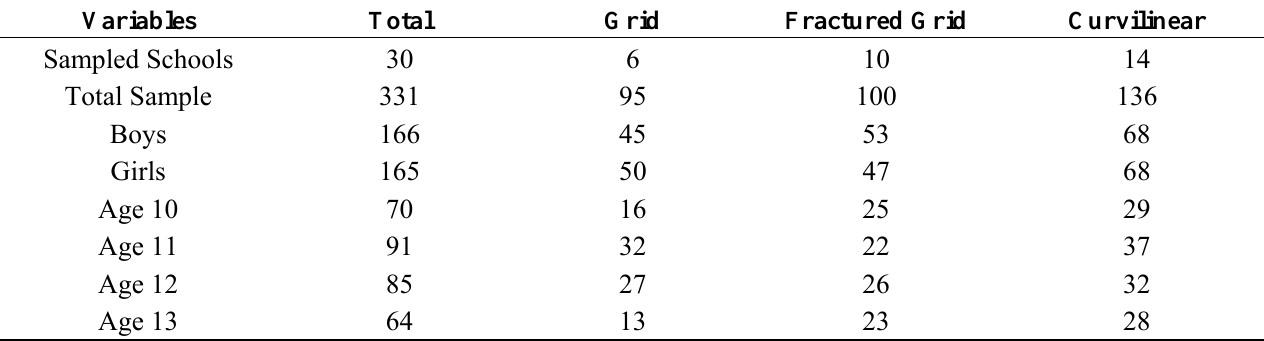
Table 2. Descriptive characteristics of the valid study sample depicted across urban